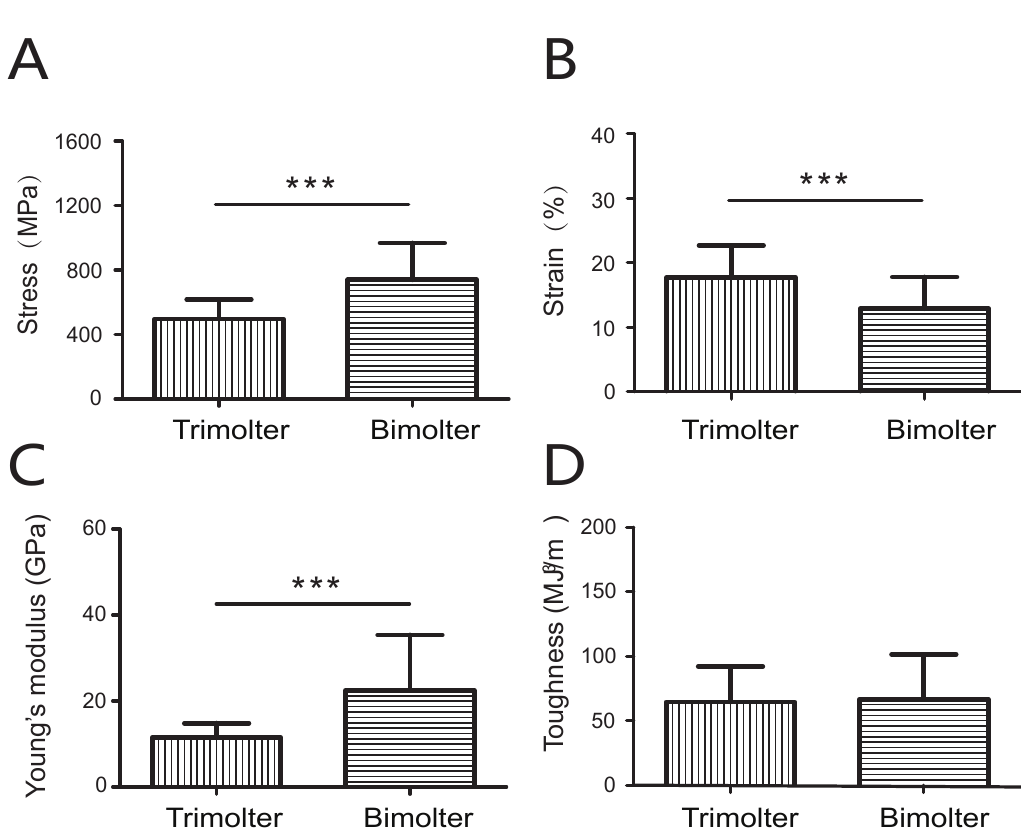
Figure 9. Mechanical parameters of silk fibers from trimolter and bimolter, n = 25. ( A ) Maximum stress. ( B ) Maximum strain. ( C ) Young’s modulus. ( D ) Toughness. *** represent p < 0.05 and p < 0.001, respectively (Student’s t -test). Error bars,